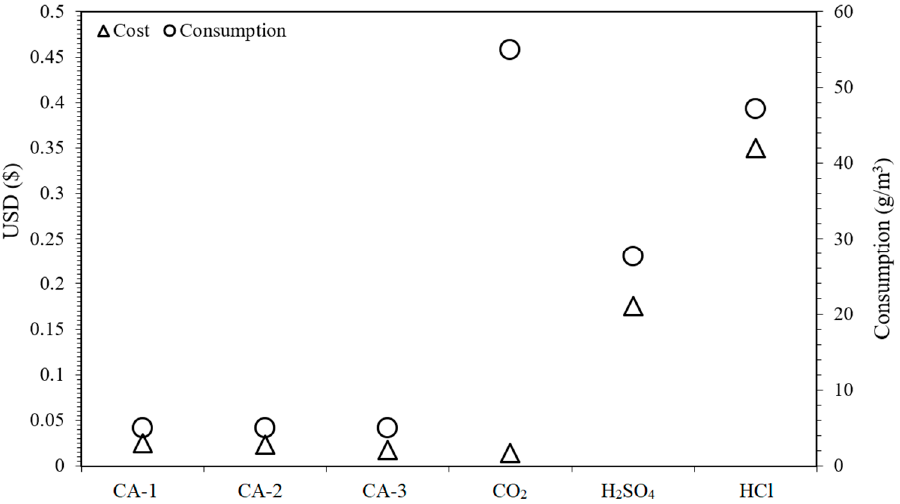
Figure 8. The comparison of consumption cost of antifouling agents during filtration of 1 m 3 influ- ent.